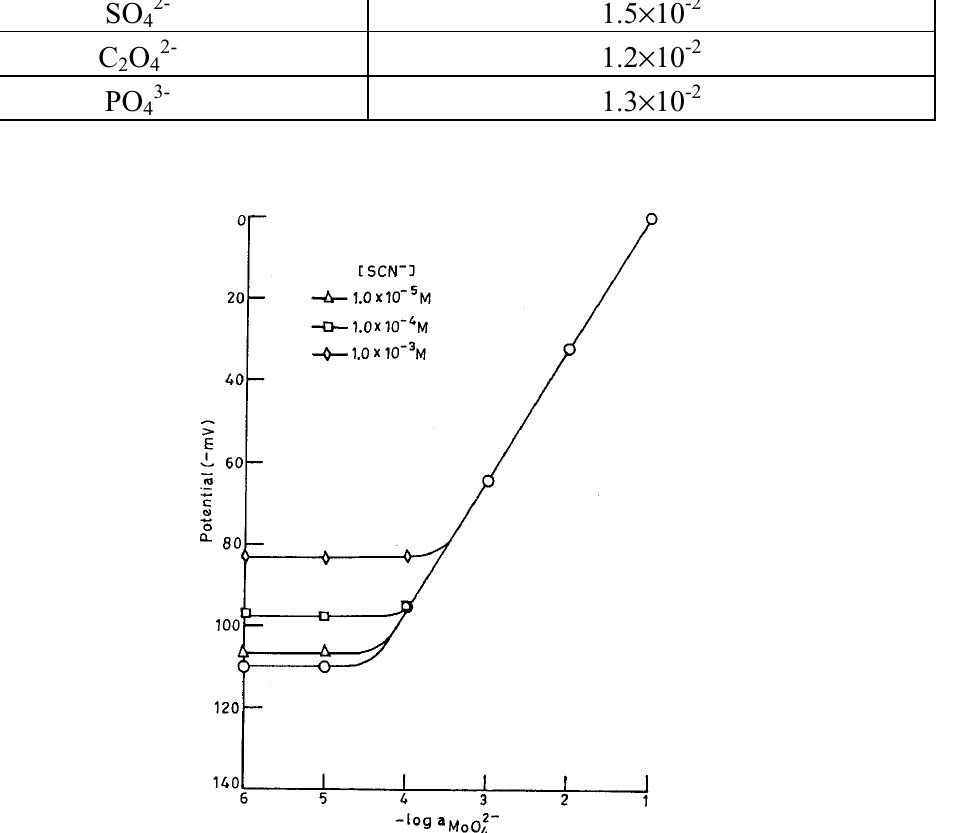
Figure 4. Variation of cell potential with varying concentrations of MoO 42- at different concentration levels of SCN - for ( I )